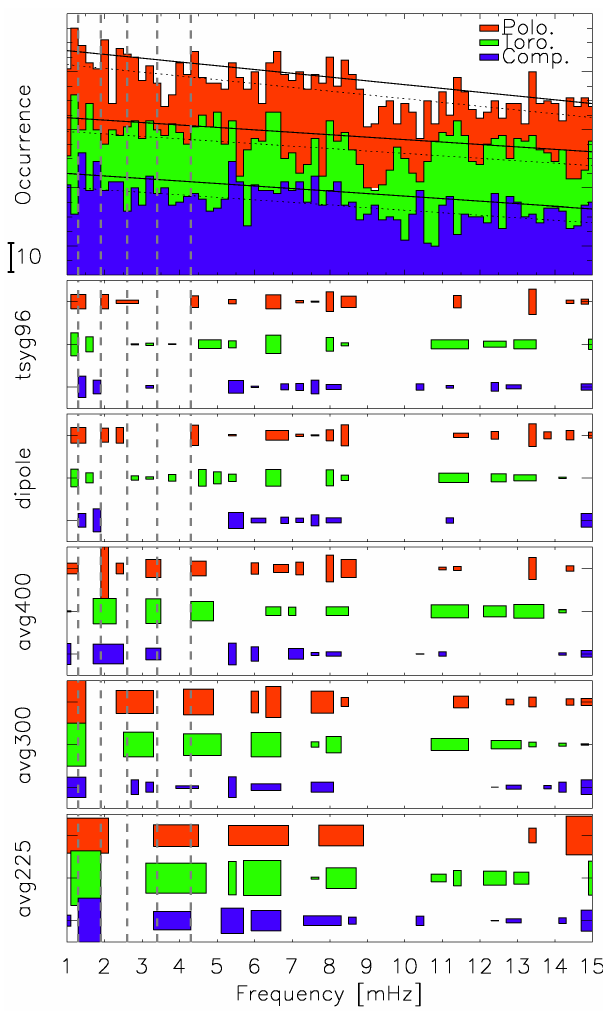
Fig. 11. Occurrence of spectral peaks in the three magnetic field components when using the T96 model (top panel). The dashed lines give the linear fit to each histogram, the solid lines shows the 95% confidence level of each fit. The second panel shows the sig- nificant peaks of each histogram. Subsequent panels show charac- teristics of significant peaks in occurrence distributions determined from different magnetic field models. See text for further